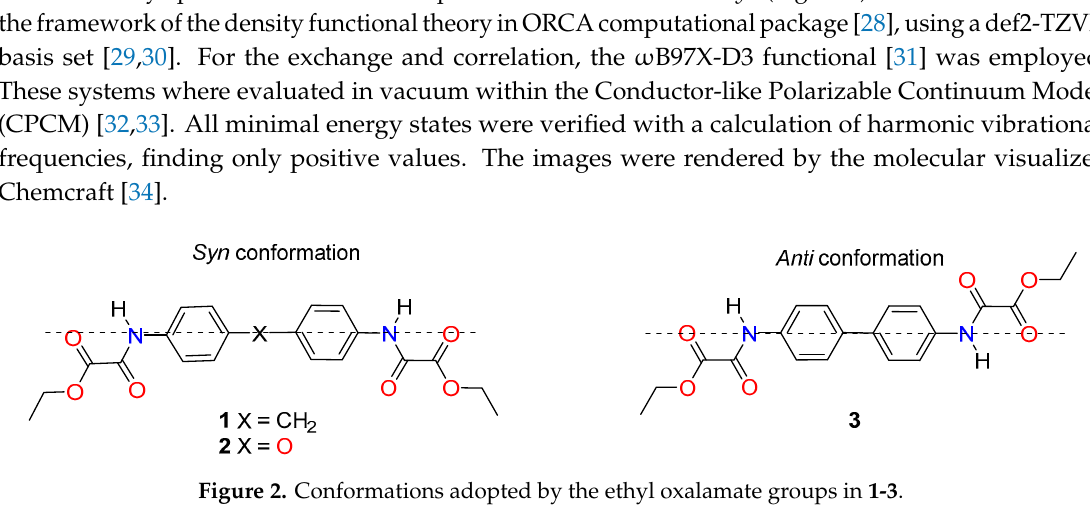
Figure 2. Conformations adopted by the ethyl oxalamate groups in 1-3 .